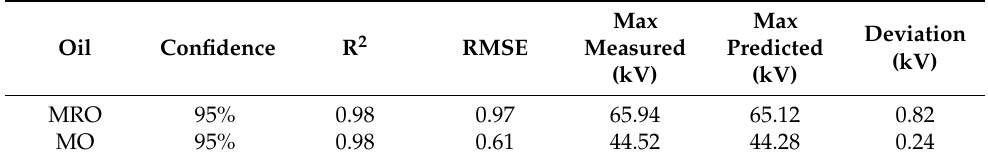
Figure 6. Measured breakdown voltage distribution using Lagrange polynomial function is compared with the predicted breakdown voltage distribution using Gaussian function. ( a ) MRO, ( b ) MO. Table 3. Variation of Gaussian prediction of the breakdown voltage of MRO and MO with 95% confidence bound with conformity more than